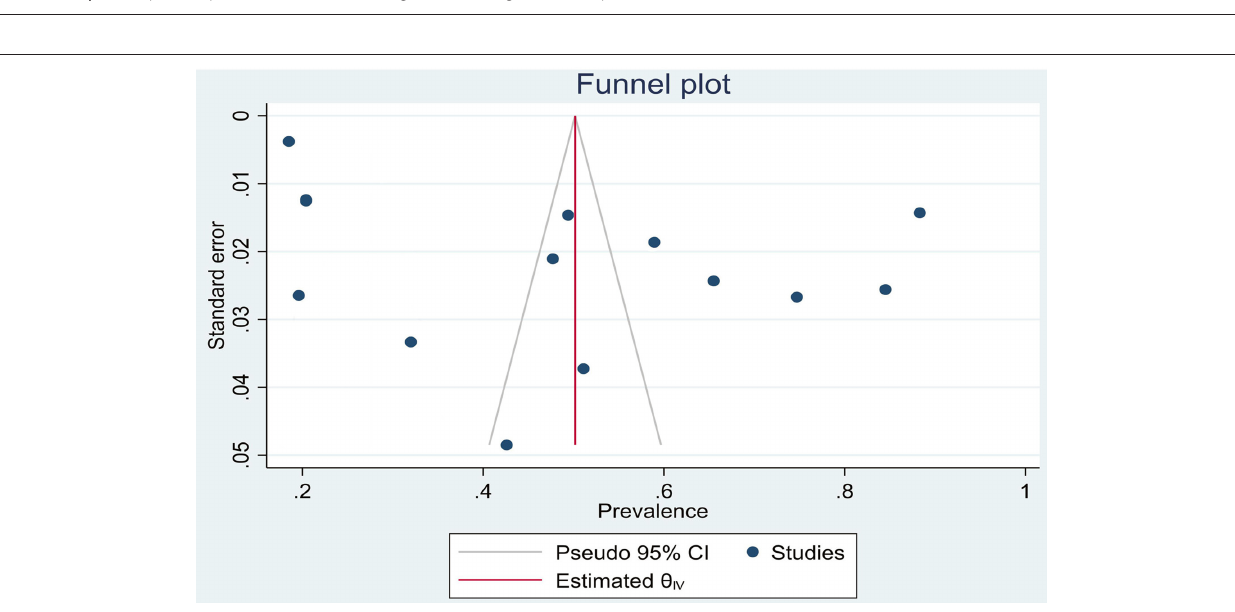
FIGURE 2 | Forest plots of prevalence of WPV among HCWs during COVID-19 pandemic.